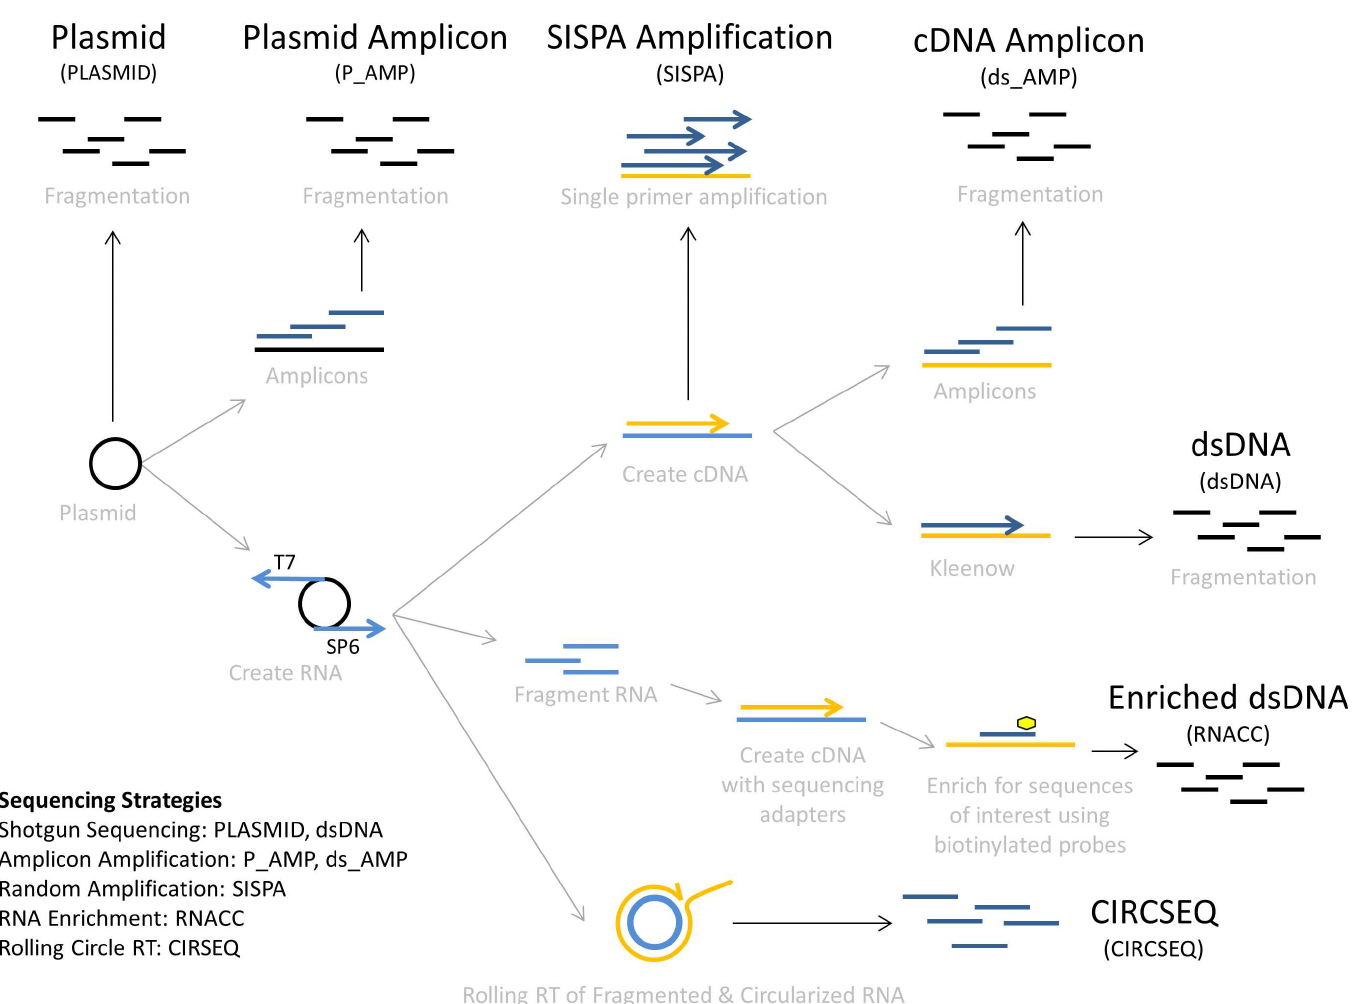
Fig 1. Study sample